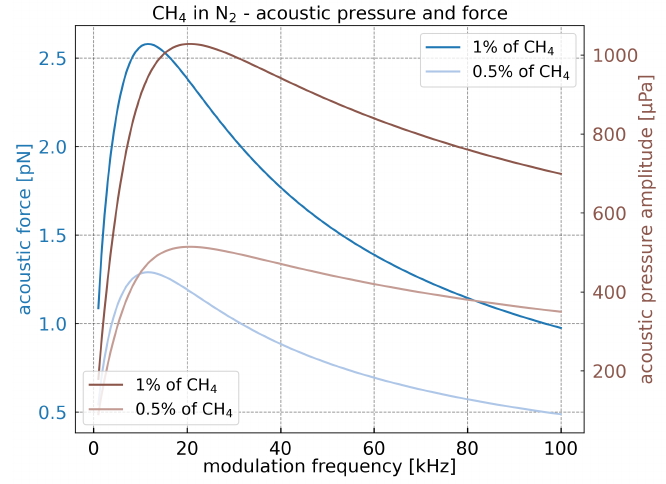
Figure 3. Acoustic force and acoustic pressure dependency on the modulation frequency for diluted CH 4 at 1% and 0.5% in nitrogen. Cantilever width b = 25 µ m and thickness h = 100 µ m.